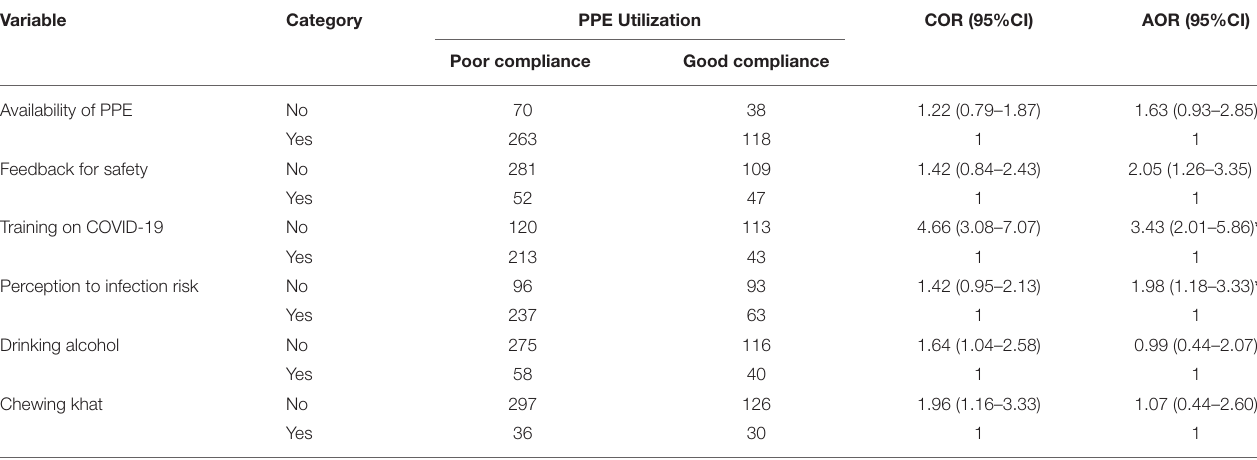
TABLE 6 | Factors associated with personal protective equipment utilization among healthcare workers toward COVID-19 in public hospitals of South Wollo Zone, Northeastern Ethiopia ( n = 489).